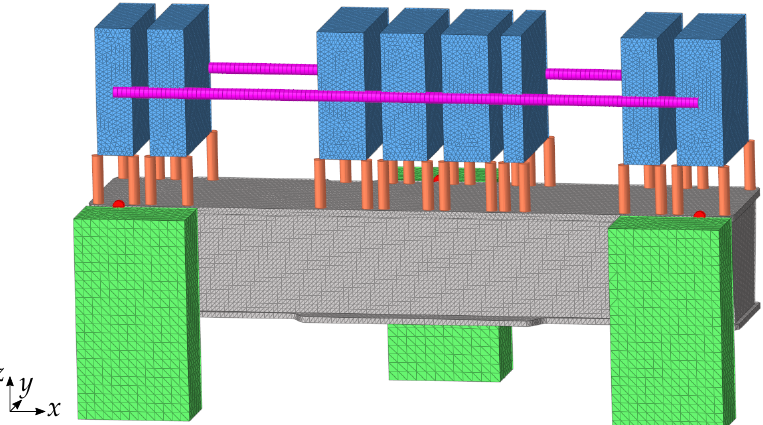
Figure 8. Parametric study model for the magnet position height study with connected magnets exemplarily displayed for the PETRA III girder. The model includes the girder (grey), the magnets (blue), and the bases (green) as well as the beams connecting the girder to the bases (red), the magnets to the girder (orange), and the magnets among each other